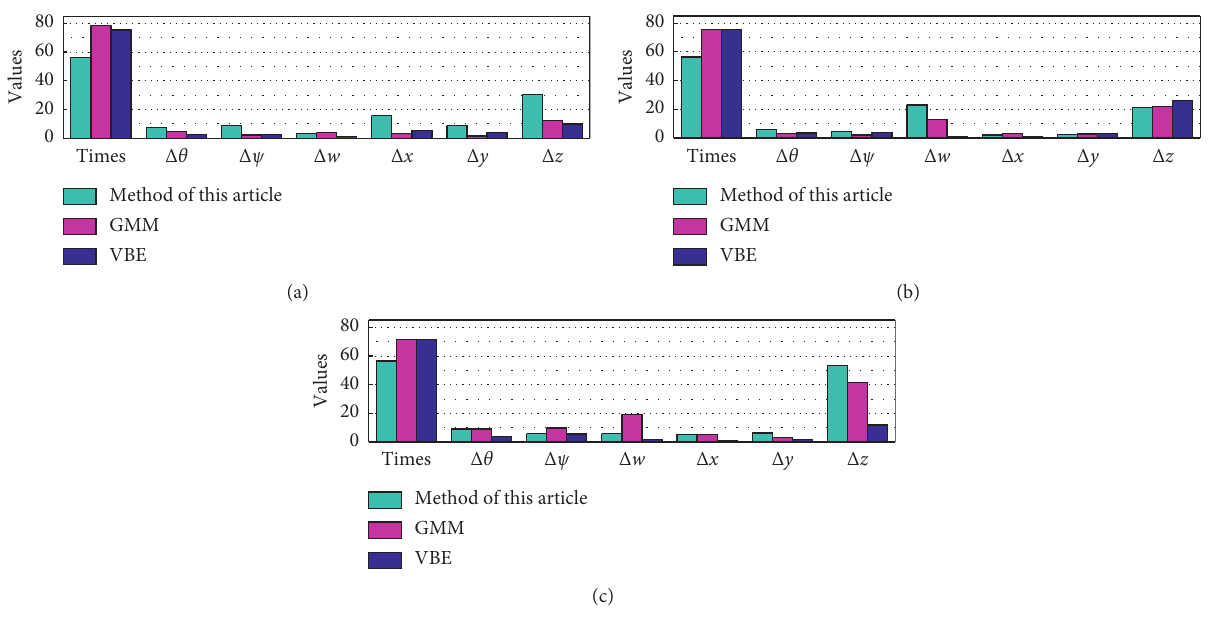
Figure 6: Curve comparison